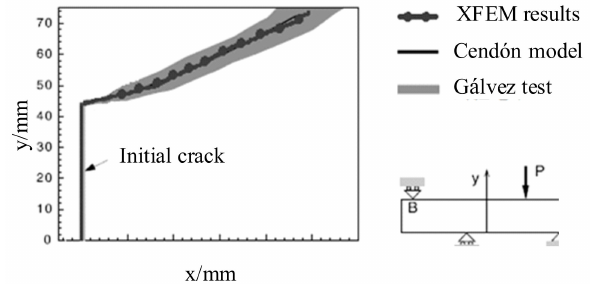
Figure 9. Simulation results of the four-point